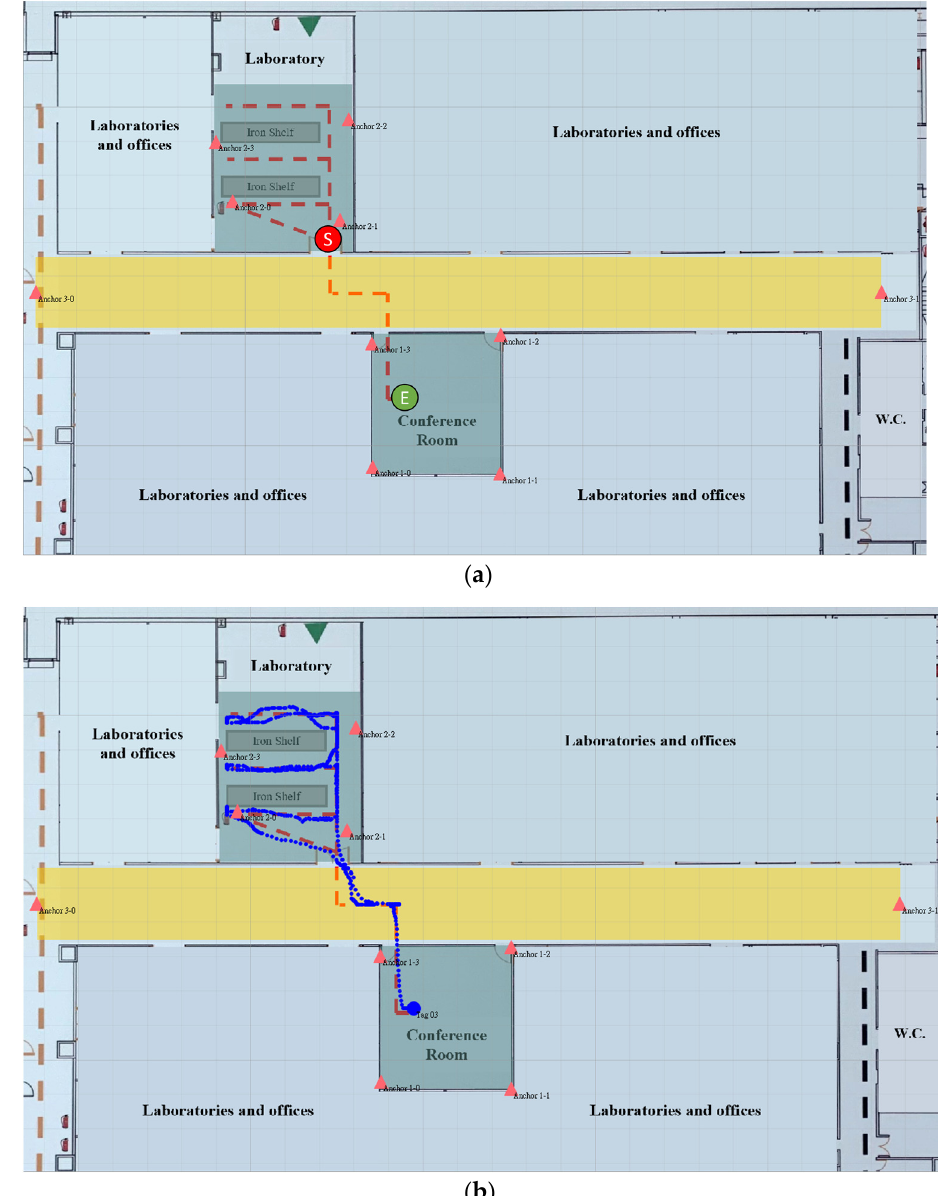
Figure 25. ( a ) Real trace and ( b ) estimated trace of tag 3.